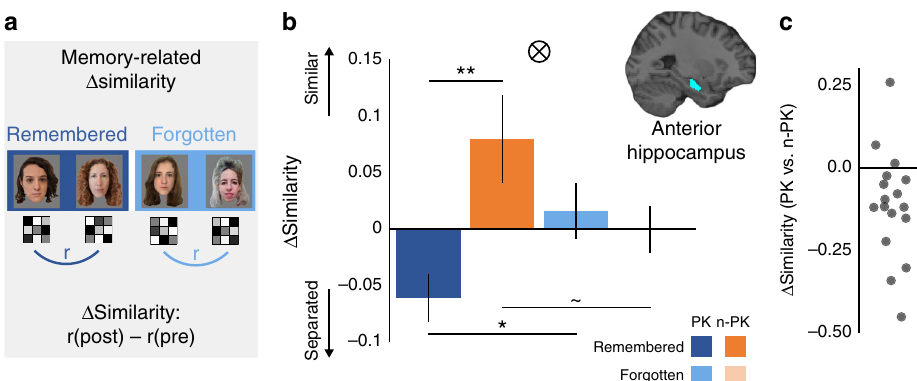
Fig. 2 Representational changes in the hippocampus are modulated by prior knowledge and mediate memory. a Pairs were grouped based on memory in the later associative memory test (remembered pairs include high-con fi dence hits), and prior knowledge (PK/no prior knowledge, n-PK). The multivoxel activity patterns of items in each pair were correlated before and after learning, and the pre- to post-learning difference in correlation values (Fisher- transformed) was calculated. b The results from the left anterior hippocampus. Similarity after learning was lower between members of PK pairs, in contrast to an increase in similarity in n-PK pairs. Similarity differences were speci fi c to remembered pairs. Δ Similarity: difference in similarity values from before to after learning. N = 18. Data in the bar graphs are presented as mean values, error bars re fl ect + / − SEM. ⊗ Interaction of pair type (PK/n-PK) by memory (remembered/forgotten) in a repeated- measure ANOVA: P = 0.0055. ** P = 0.008, * P = 0.02, ~ P = 0.07, the results of a paired-sample two- tailed t test between pairs of conditions, as depicted by the black lines. c Dots re fl ect individual participants ’ Δ Similarity reduction due to prior knowledge (PK-remembered pairs minus n-PK-remembered pairs). To protect copyrights, all faces in the fi gures are of novel faces, and we obtained permission to use these photos. Participants in the study saw famous and novel faces, as detailed in the Methods.